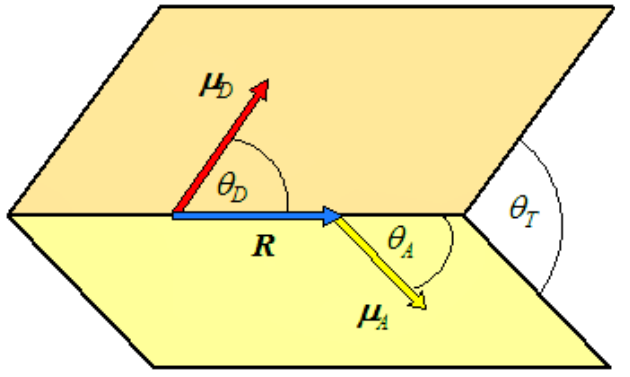
Figure 2. Relative orientations and positions of donor and acceptor and their transition moments: angles θ and θ are subtended by the donor and acceptor dipole transition D A moments ( μ and μ , respectively) against the inter-chromophore displacement vector, R ; D A θ is the angle between the transition T